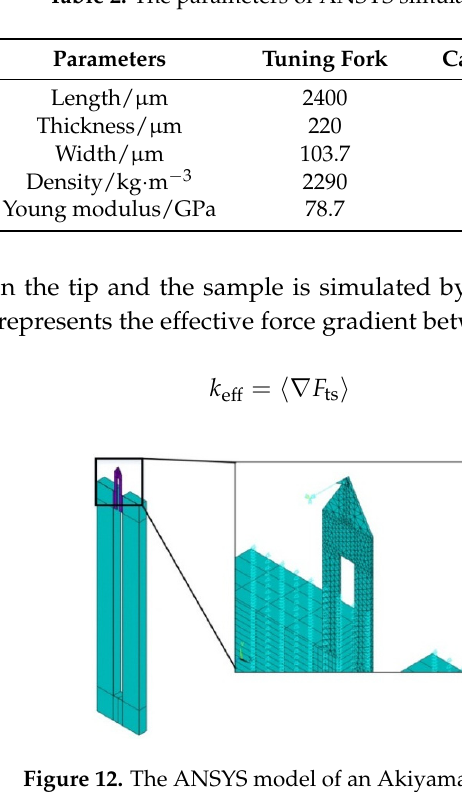
Figure 12. The ANSYS model of an Akiyama probe.